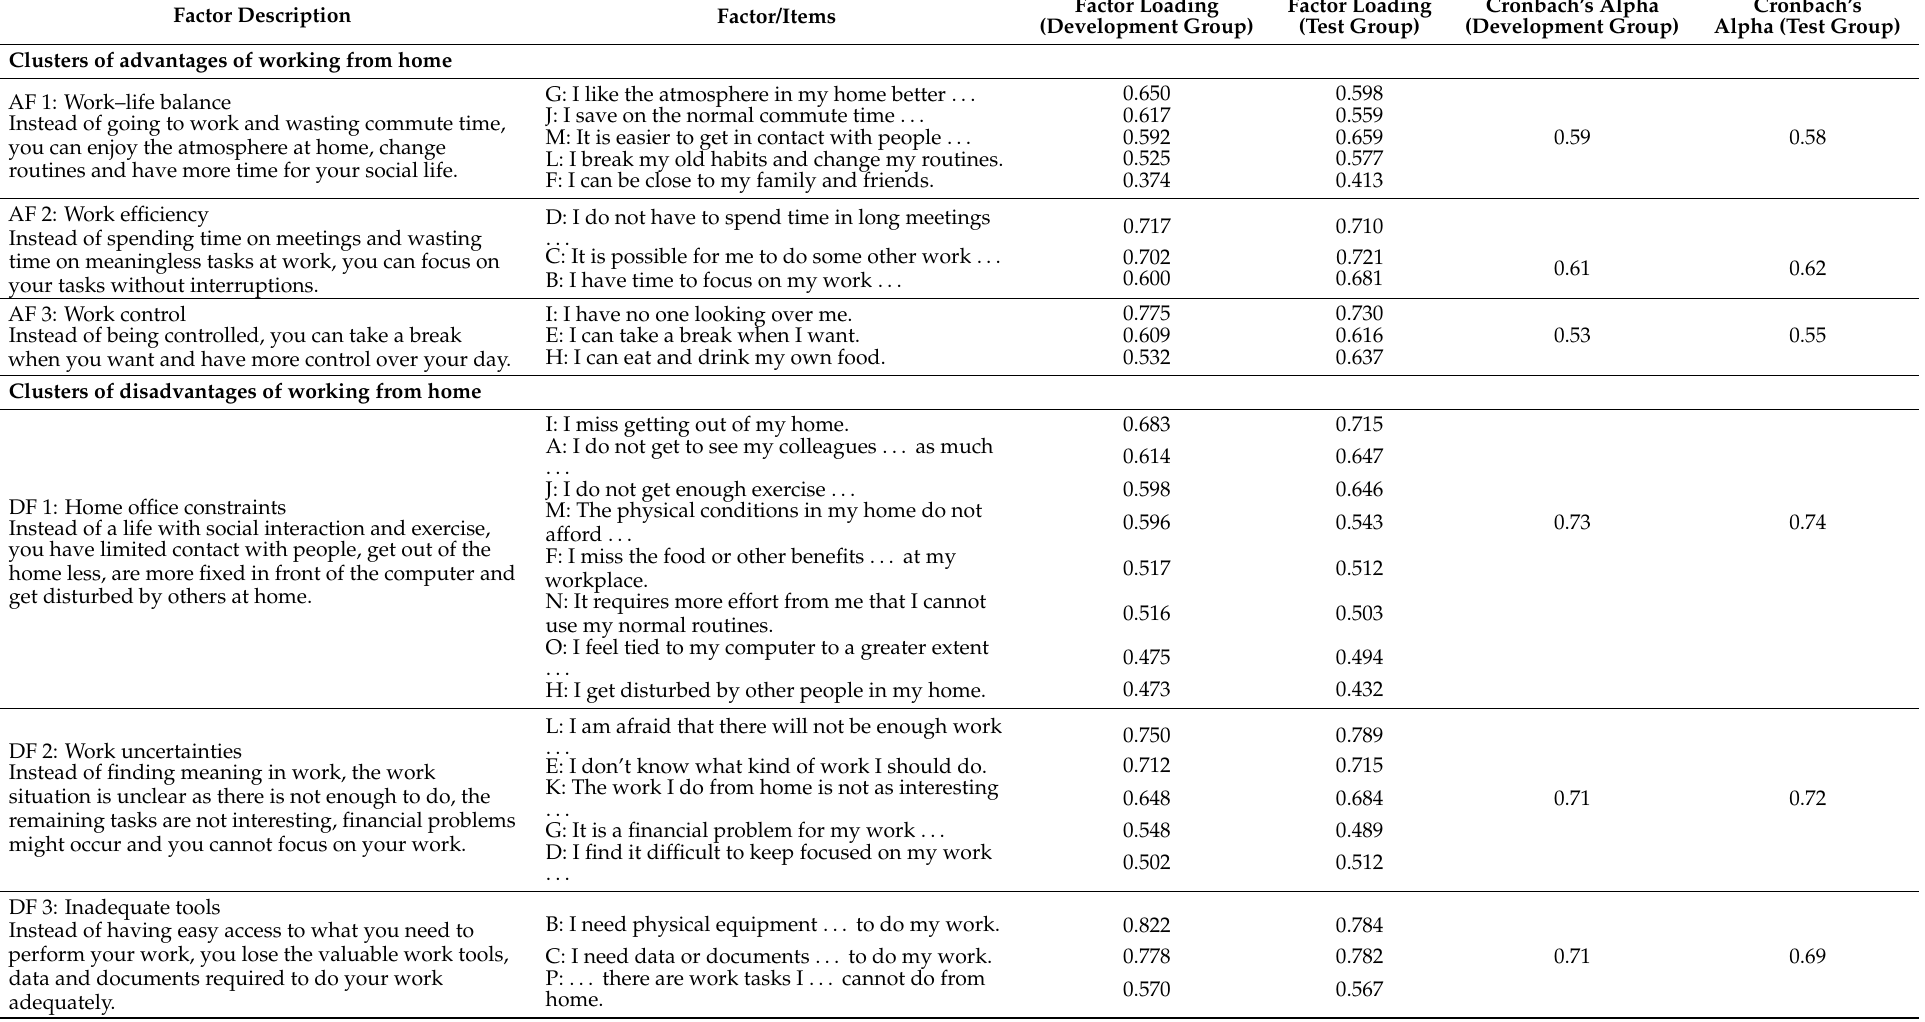
Table 3. Results of the exploratory factor analysis (varimax